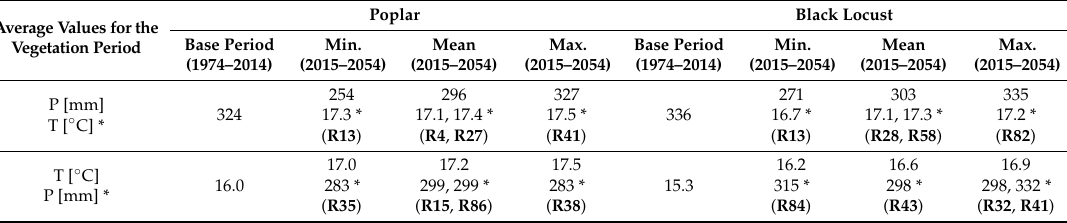
Table 2. Realisations (R, highlighted in parentheses) that rendered minimum, mean, and maximum average precipitation sum (P) and air temperature (T) values with respect to the vegetation period of both tree species and under a timeframe of forty years.